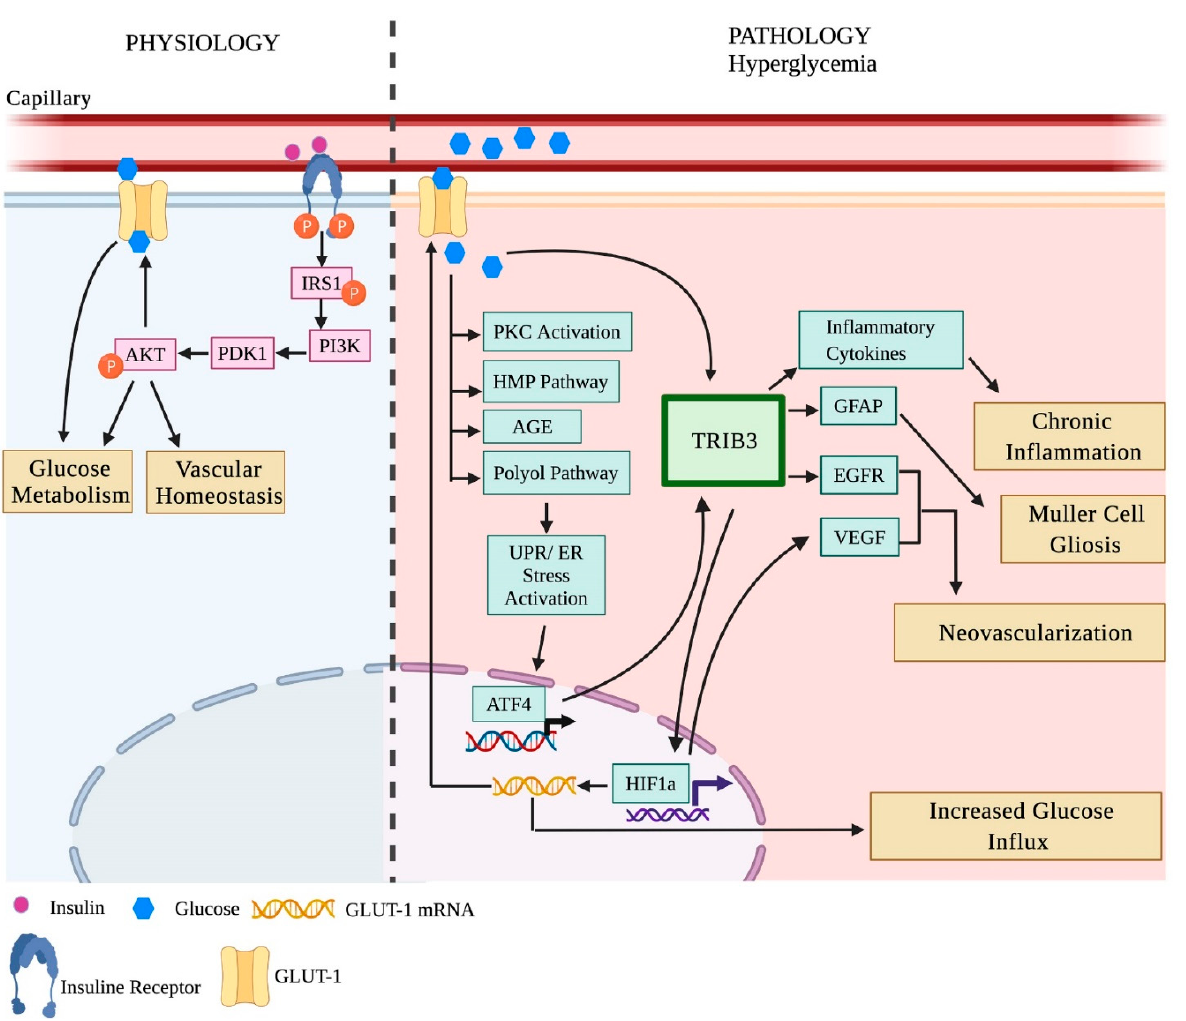
Figure 1. Tribbles homolog 3 (TRIB3) protein controls the development and progression of diabetic retinopathy. The PERK UPR marker TRIB3 is a known psuedokinase that binds and prevents AKT phosphorylation by PDK1. In addition, it controls the expression of HIF1 α , EGFR, GFAP, and inflammatory cytokines in cells. In hyperglycemic retinas and retinas of mice with proliferative retinopathy, TRIB3 is significantly upregulated. This results in overexpression of HIF1 α , EGFR, GFAP, and inflammatory cytokines (Icam1, Nf-kb1, Rc3h1, Zc3h12a, VEGF, COX2, and AIF1, [84]). In turn, overexpressed HIF1 α leads to GLUT1 activation and, together with TRIB3, increases the influx of glucose, which affects the overall glucose metabolism in diabetic retinas. Aberrant glucose flux and hyperglycemia in diabetic retinas are responsible for the activation of PKC, HMP, AGE, and polyol pathways, which eventually leads to chronic UPR activation. TRIB3-mediated pro- inflammatory cytokine expression results in chronic inflammation, GFAP increase leads to the retinal gliosis observed in proliferative retinas, and VEGF elevation triggers neovascularization in the late stages of DR. Image created by Biorender.com, (accessed on 30/05/2021). Changes in inflammatory gene expression across varied rodent models of DR have also been reported. For example, six-week-old ZFD rat retinas manifest an increase in the levels of TNF- α and NF-kB [113]. Inflammatory proteins such as clusterin, the tissue inhibitor of metalloproteinase (TIMP)-1, β -2 microglobulin, and von Willebrand factor were overexpressed in the SD rat retinas at four weeks and, particularly, at three months